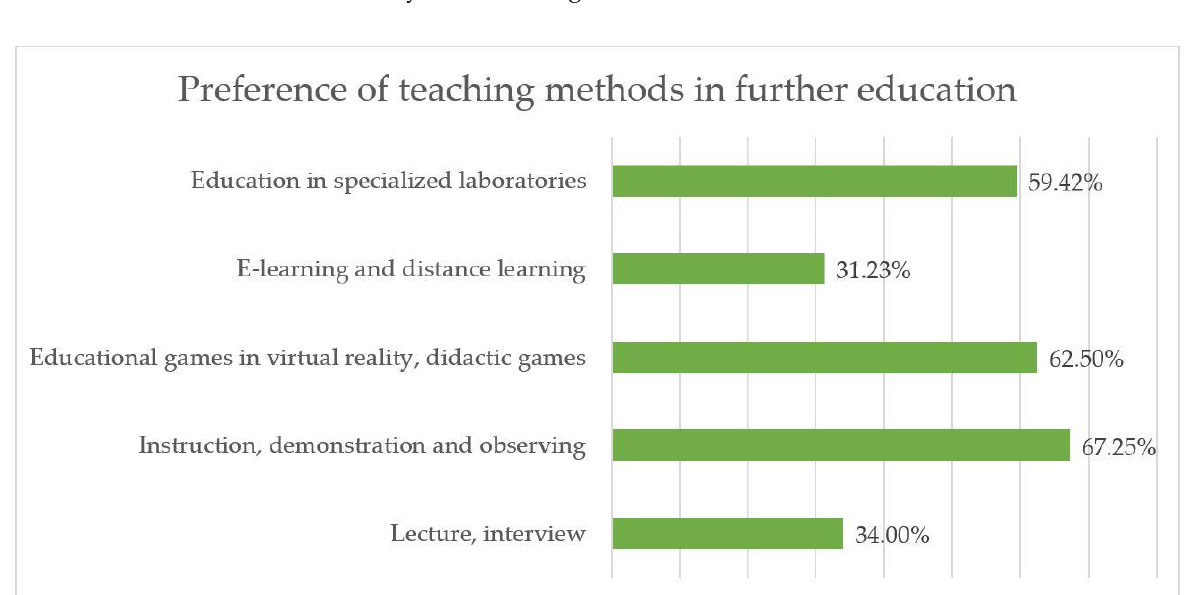
Figure 12. Preference of teaching methods in further education.